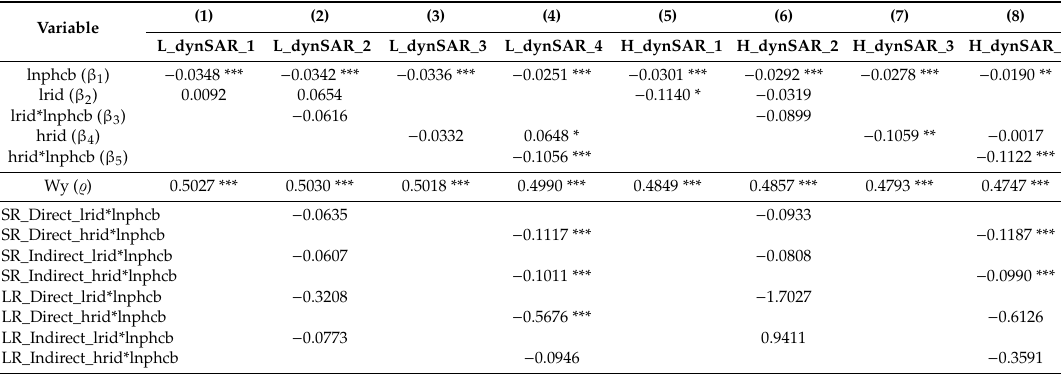
Table 5. Further Analysis of heterogeneous food price risk